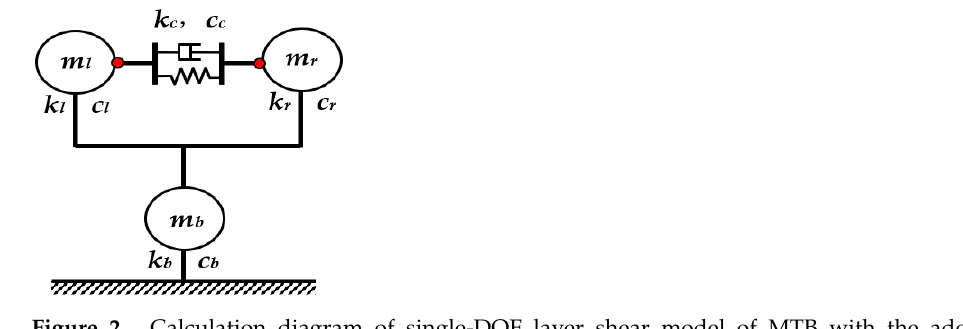
Figure 2. Calculation diagram of single-DOF layer shear model of MTB with the adopted CPC method .